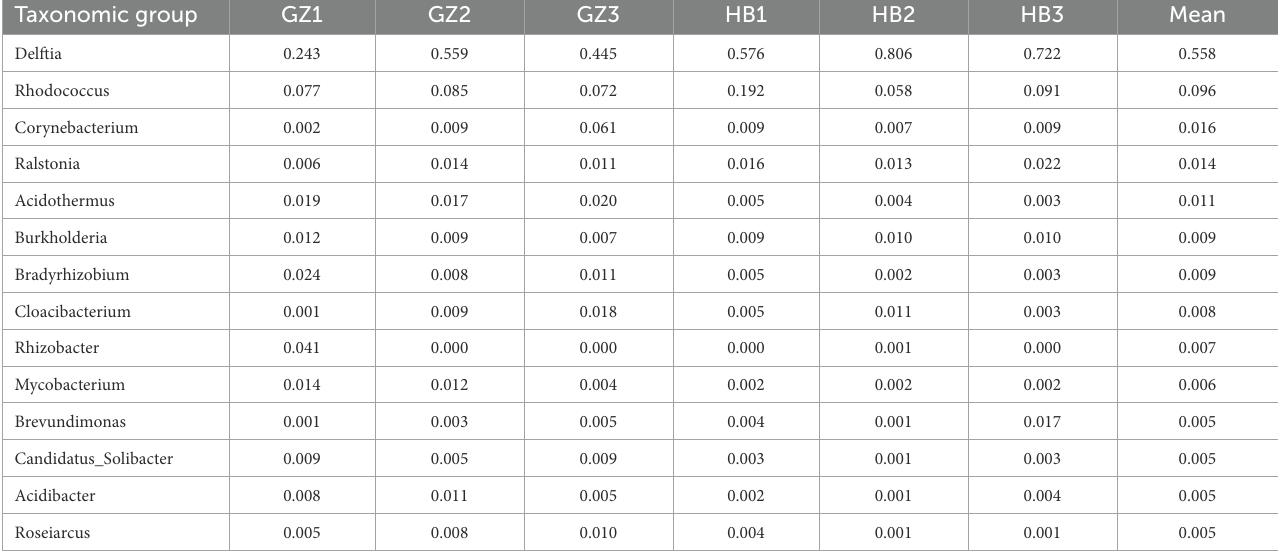
TABLE 3 Summary statistics for the relative abundances of major taxonomic groups (mean ≥ 5%). Taxonomic